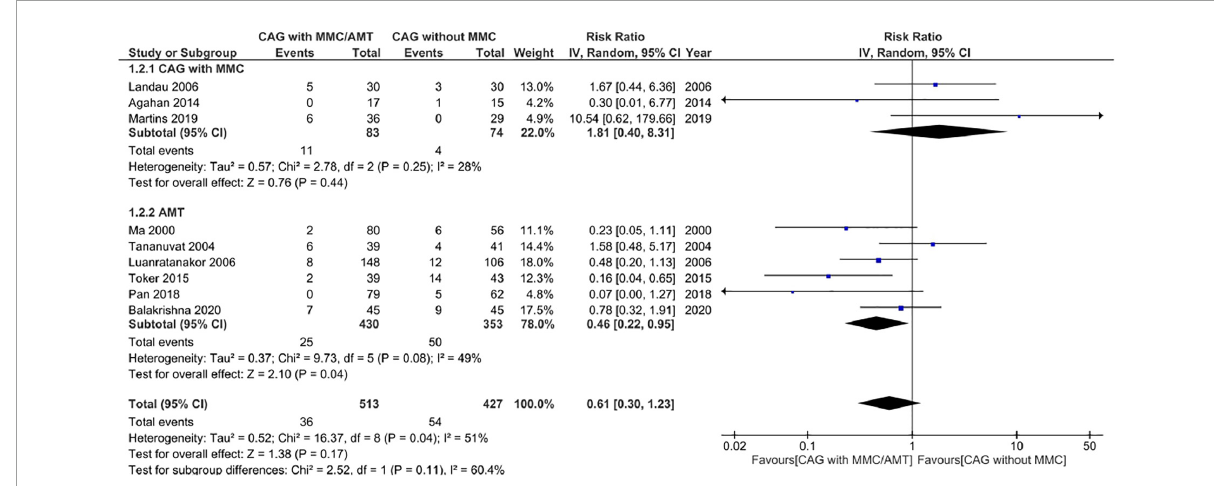
FIGURE7 Forrest plot of adverse events. CI, confidence interval; IV, inverse variance; CAG, conjunctival autograft; AMT, amniotic membrane transplantation; MMC, mitomycin C.